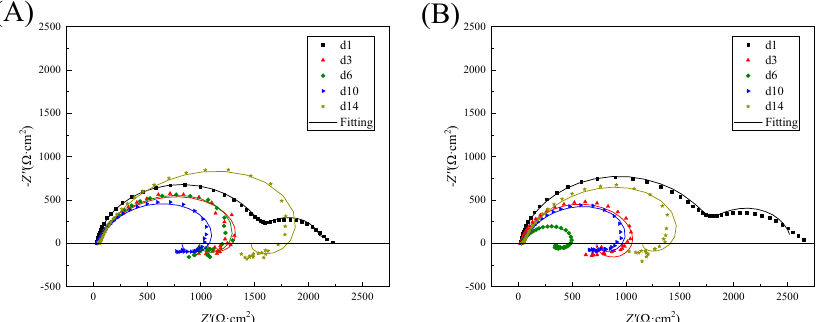
Figure 8. Nyquist plots of AZ31B magnesium alloy in different corrosion conditions recorded at different times. ( A ) abiotic mud, ( B ) biotic mud. Table 2. Fitted electrochemical parameters for AZ31B magnesium alloy after immersion in biotic mudflat.